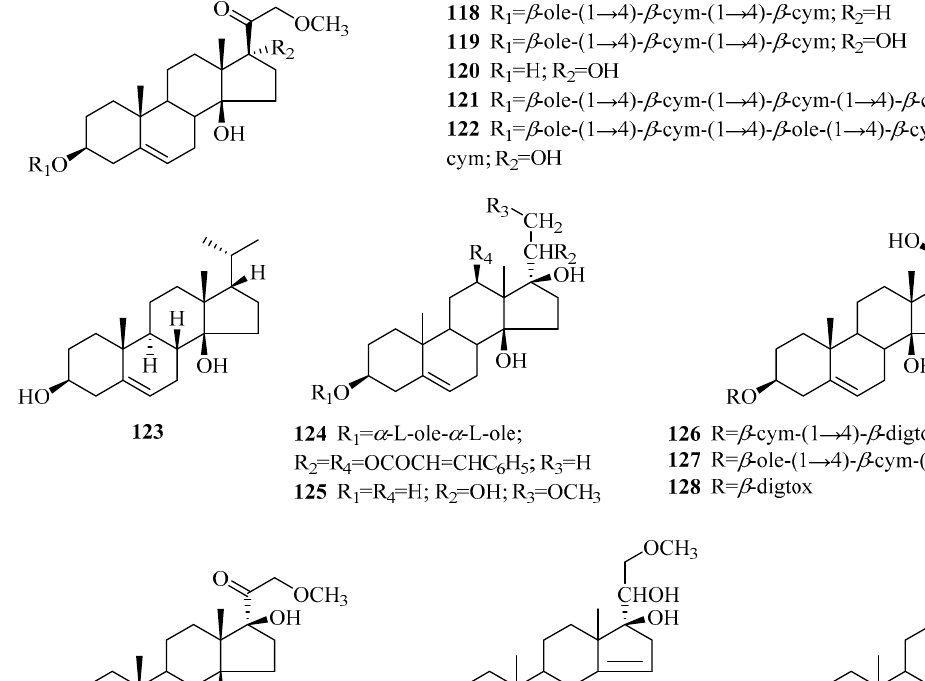
Figure 4. Phytosterol-type steroids from the genus Periploca .